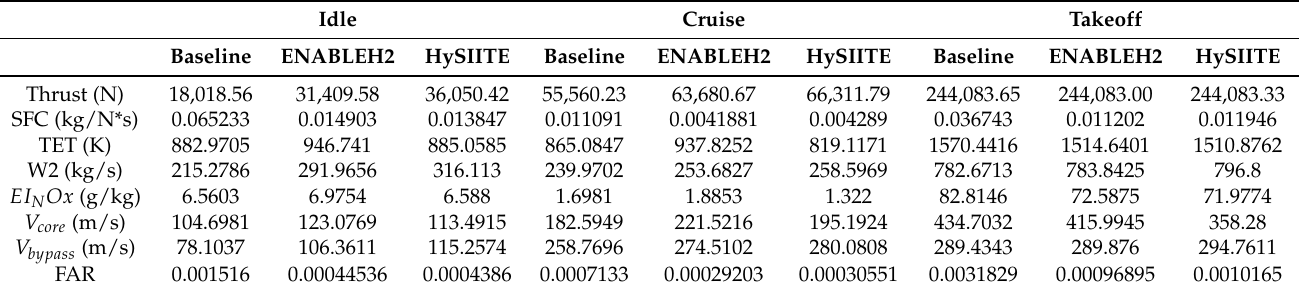
Table 3. Simulation results of key performance parameters of three configurations under different operating points.